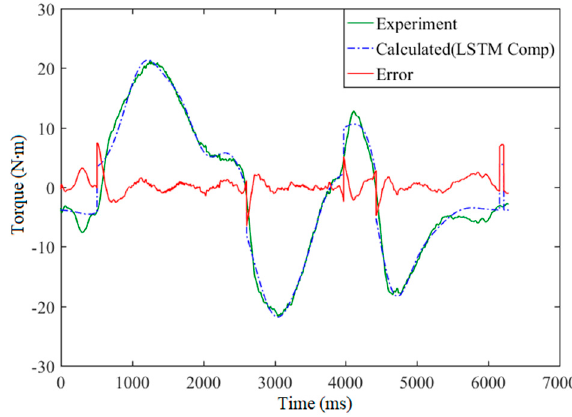
Figure 13. Calculated torque with LSTM compensation, actual torque, and errors of axis 5. Table 2. RMS Error of Calculated Torque between Real Value.